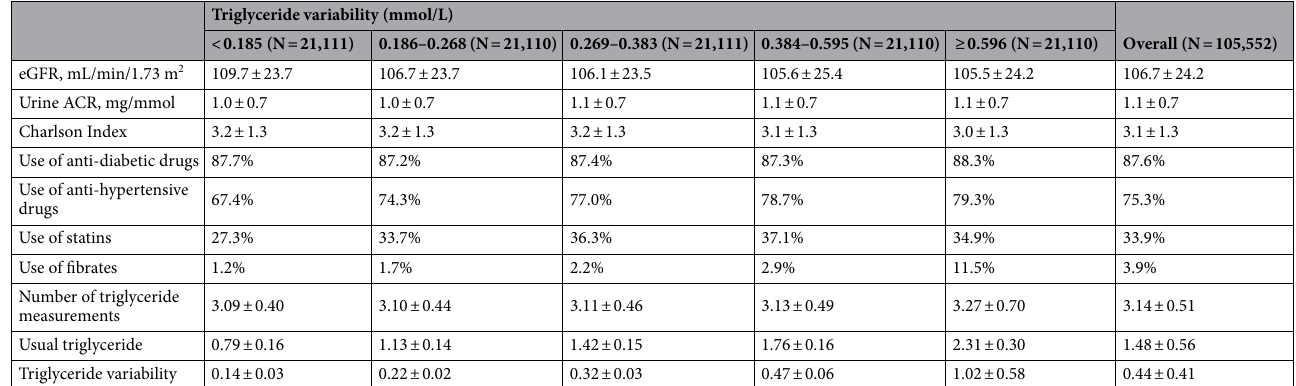
Table 1. Descriptive statistics for baseline characteristics among patients stratified by LDL-C, TC to HDL-C ratio and triglyceride variability. All parameters are expressed in either percentage or mean